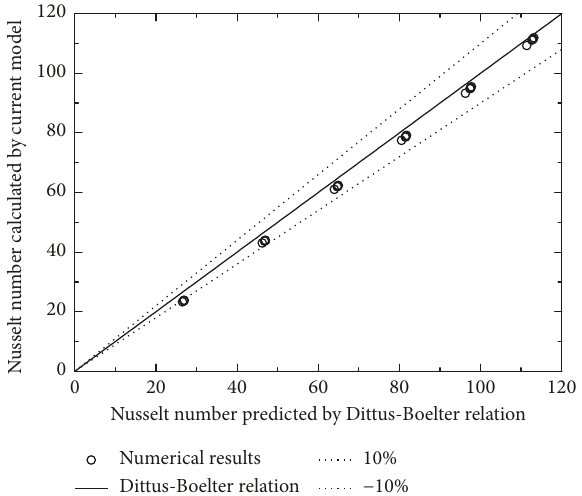
Figure 3: Comparison of calculated Nusselt number of nanofluids with Dittus–Boelter